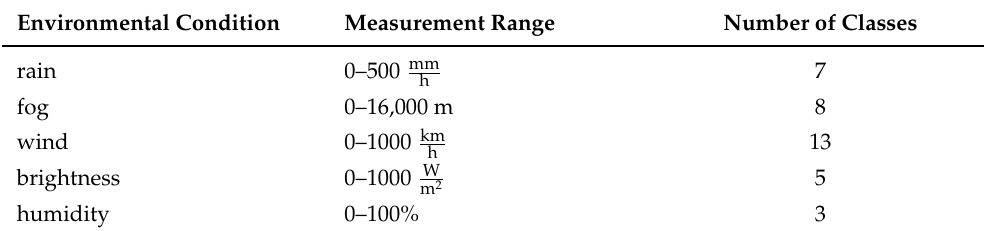
Table 5. Overview of the classifications of five selected environmental